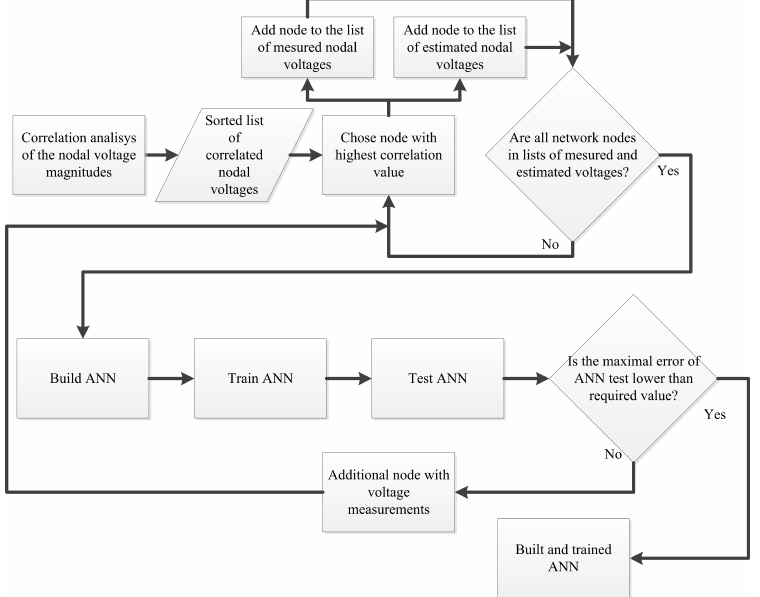
Figure 3. The procedure for determining the number of ANN inputs and outputs—Step A2 in a closed loop with Step